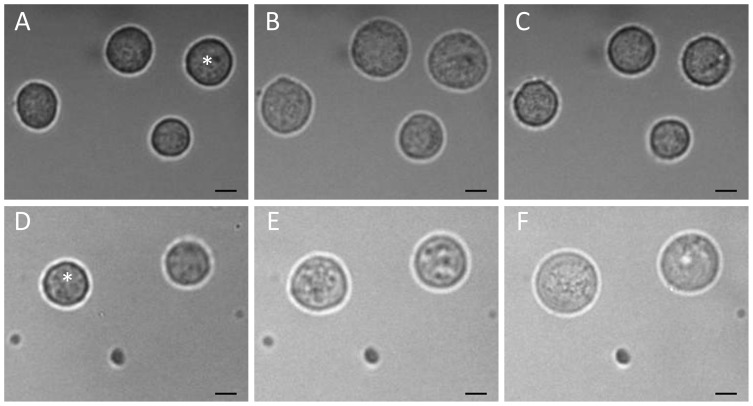
Volume changes in GaMG cells induced by strongly hypotonic sucrose- (A–C) and inositol-substituted solutions (D–F) of osmolalities 100 and 50 mOsm, respectively.The microphotographs were taken before (A and D, isotonic CGM), about 3 min (B, E) and 20 min (C, F) after an acute hypotonic shock. In hypotonic sucrose (A–C), the volume of the indicated cell increased 2.1-fold within 3 min after hypotonic shock (B). Thereafter, the cell gradually shrank via the RVD mechanism and reduced its volume to ∼120% of the original isotonic value (C). In sharp contrast to the disaccharide sucrose, the small organic osmolyte inositol fully abolished RVD in GaMG cells (D–F). Thus, upon exposure to 50-mOsm inositol, the cell volume increased first rapidly 1.6-fold at 3 min (E), and then slower, more than 3-fold within the following 20 min (F). The scale bars correspond to 10 µm.